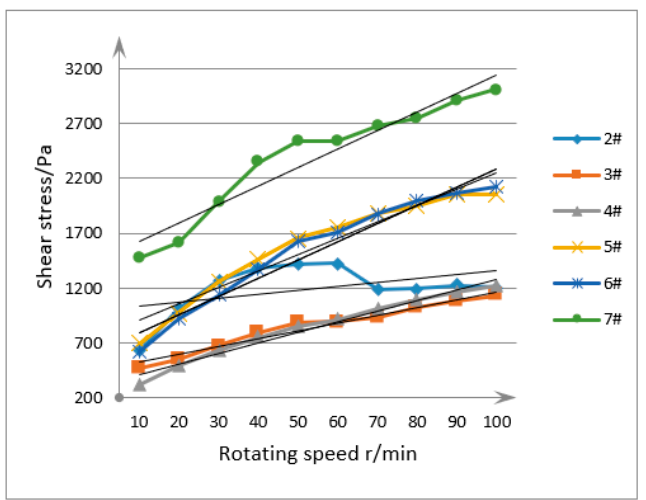
Figure 10. The initial flow properties (shear stress-shear rate variation) of the samples.